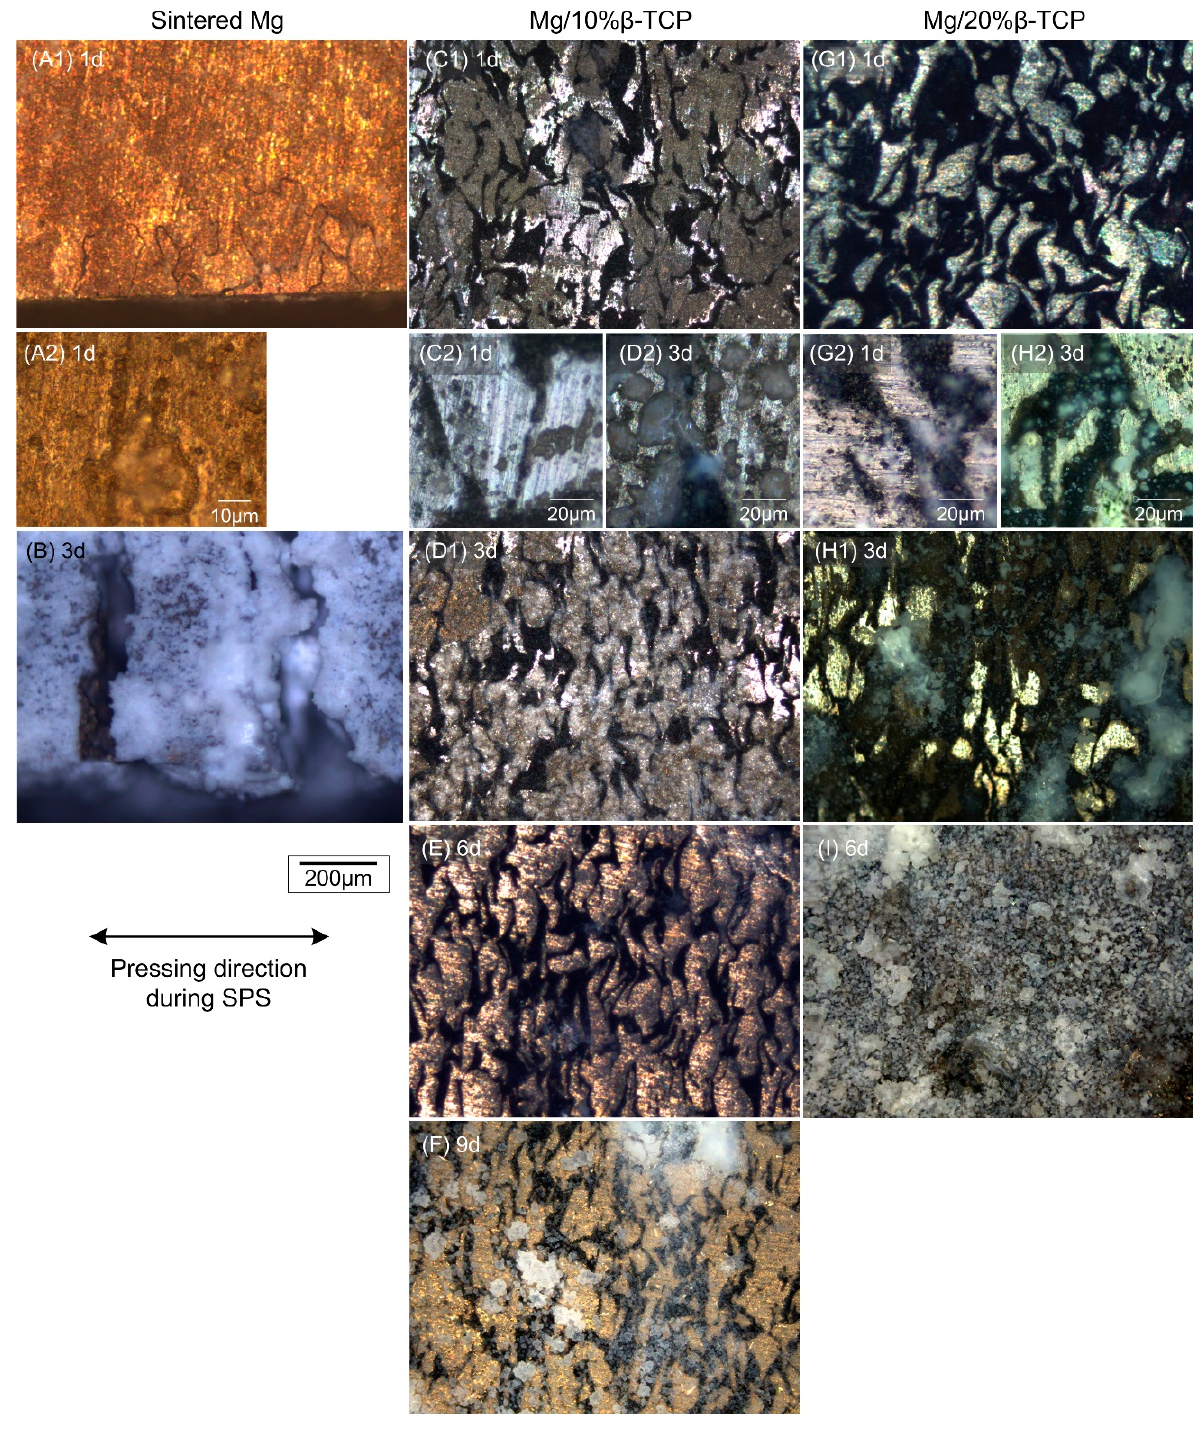
Figure 4. Optical micrographs of the ( A1 ) sintered Mg after immersion for 1 day and ( B ) 3 days; ( C1 ) Mg/10% β -TCP after immersion for 1 day, ( D1 ) 3 days, ( E ) 6 days, and ( F ) 9 days; ( G ) Mg/20% β -TCP after immersion for 1 day, ( H1 ) 3 days, and ( I ) 6 days. ( A2 , C2 , D2 , G2 , H2 ) high-magnification images of ( A1 , C1 , D1 , G1 , H1 ), respectively.